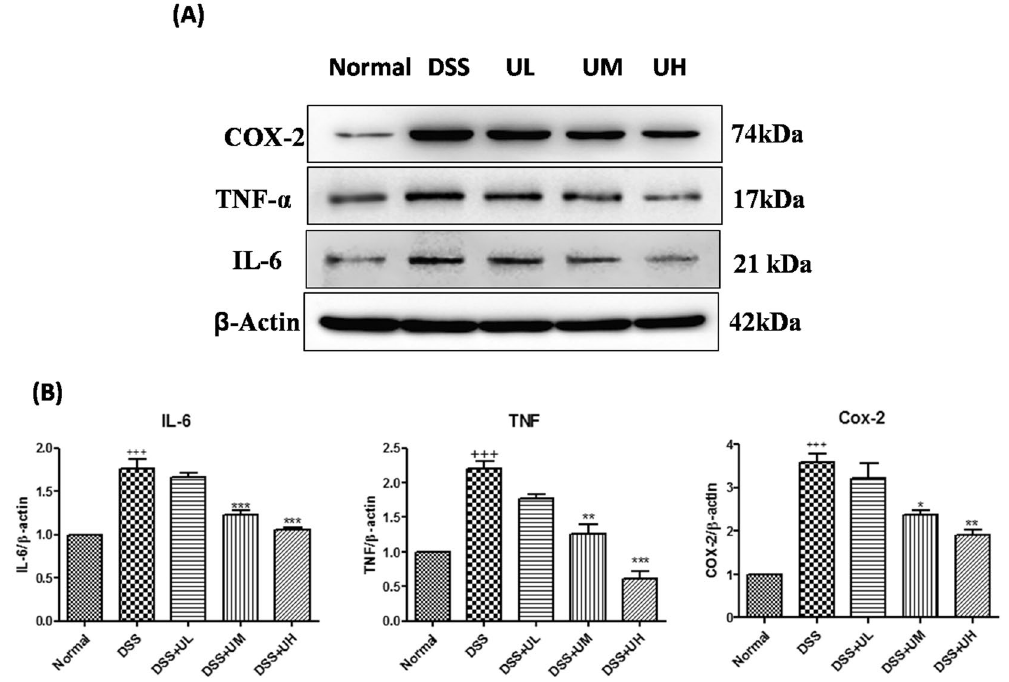
Figure 6. Effect of uridine treatment on the protein expression of pro-inflammatory cytokines, enzyme levels in colon tissue. ( A ) Representative western blots showing changes in the protein expression of pro-inflammatory cytokines and enzyme, TNF, IL-6, and COX-2 in colon tissue ( B ) Graphical depiction of western blotting analysis showing quantitative results. Band intensities were quantified using NIH Image J software. The relative protein levels were normalized to the b-actin level. Each value was calculated on the basis of the data obtained from three independent experiments. Values are the mean ± SEM (n = 3). +++ p < 0.001 vs Normal, * p < 0.05, ** p < 0.01 and *** p < 0.001 vs DSS